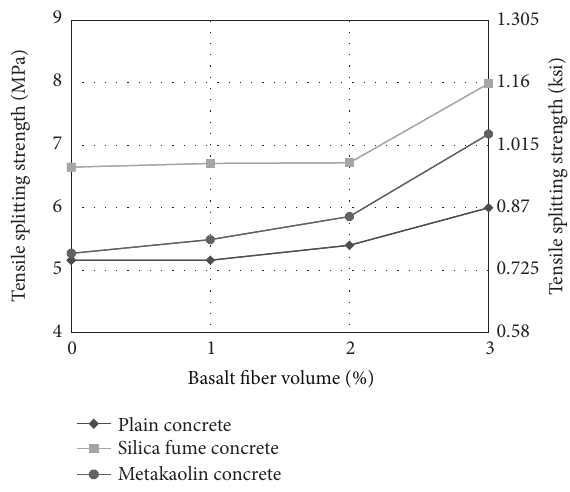
Figure 7: Variation in the splitting tensile